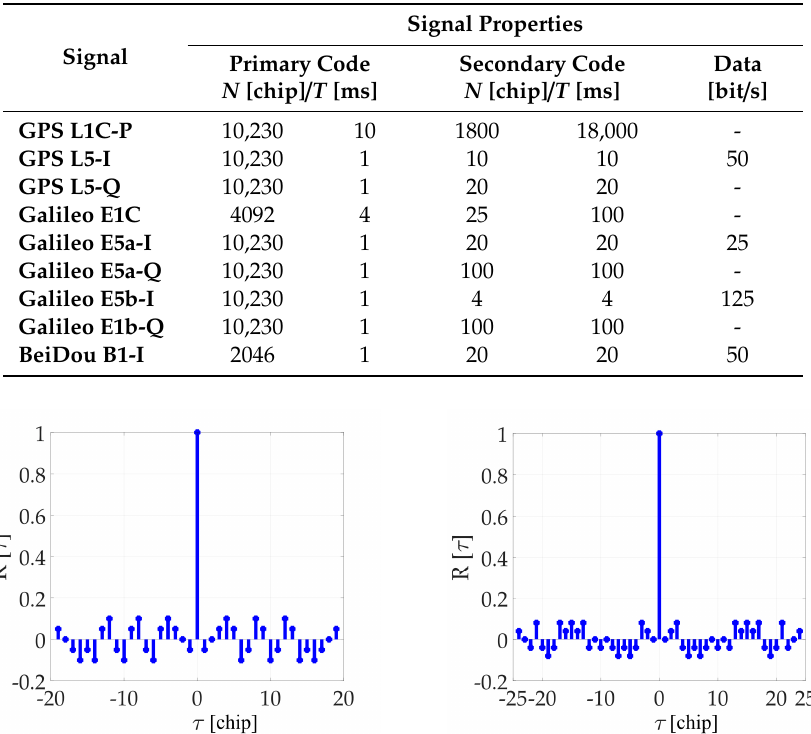
Figure 1. BeiDou-B1 (Neumann–Hoffman, left ) and Galileo E1C (CS25 1 , right ) autocorrelation function of SC.